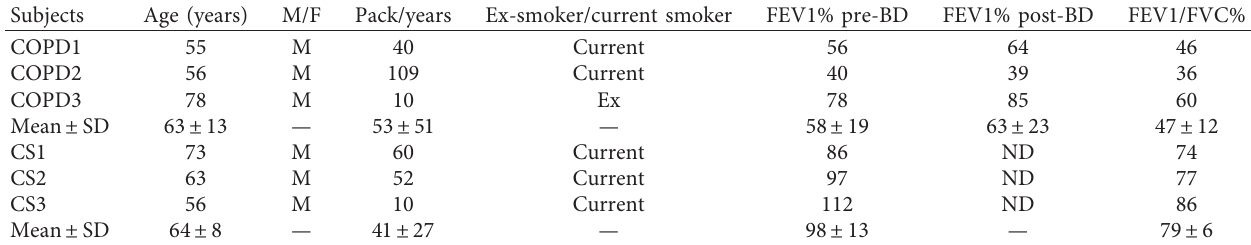
Table 1: Clinical characteristics of chronic obstructive pulmonary disease (COPD) patients and control smokers who provided bronchial fibroblasts for “in vitro” experiments.